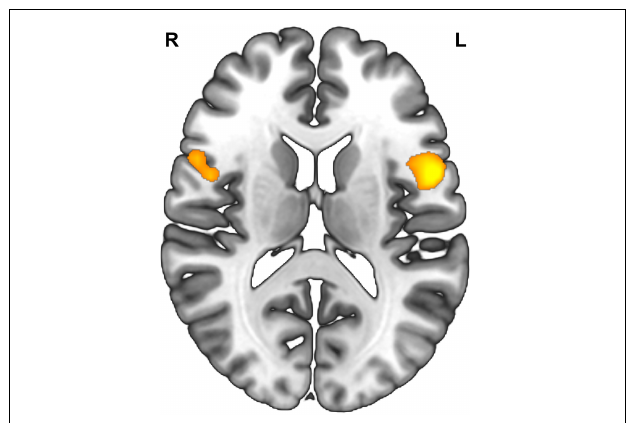
FIGURE 1 | Result of voxel-wise functional connectivity. Brain regions whose degree centrality correlated with reappraisal scores. Statistical threshold of P uncorrected < 0.005 was used for cluster